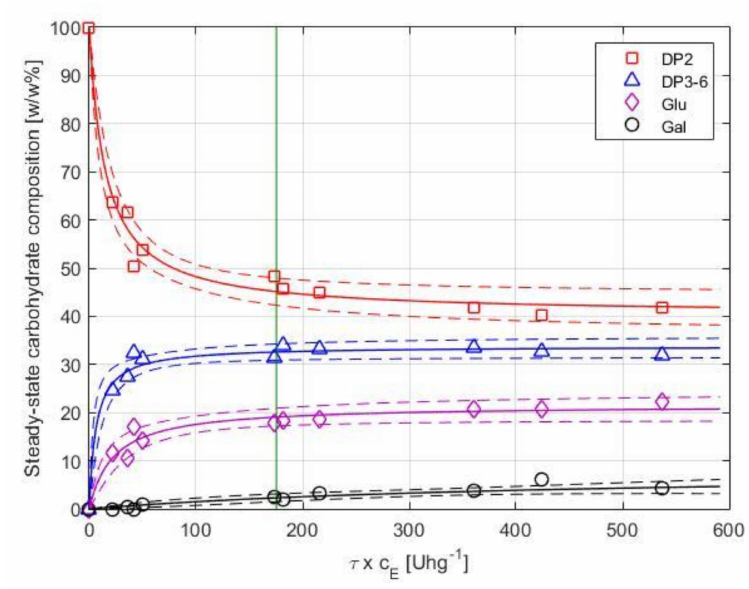
Figure 6. Steady-state saccharides’ composition as function of τ × c E for short-term runs. Experimental data, fitted regression models, and simultaneous 95% confidence bounds are illustrated with symbols, solid lines, and dashed lines, respectively. Data obtained for long-term runs L1 and L2 at 8 h of operation is highlighted with a vertical line at τ × c E = 175.4 U · g − 1